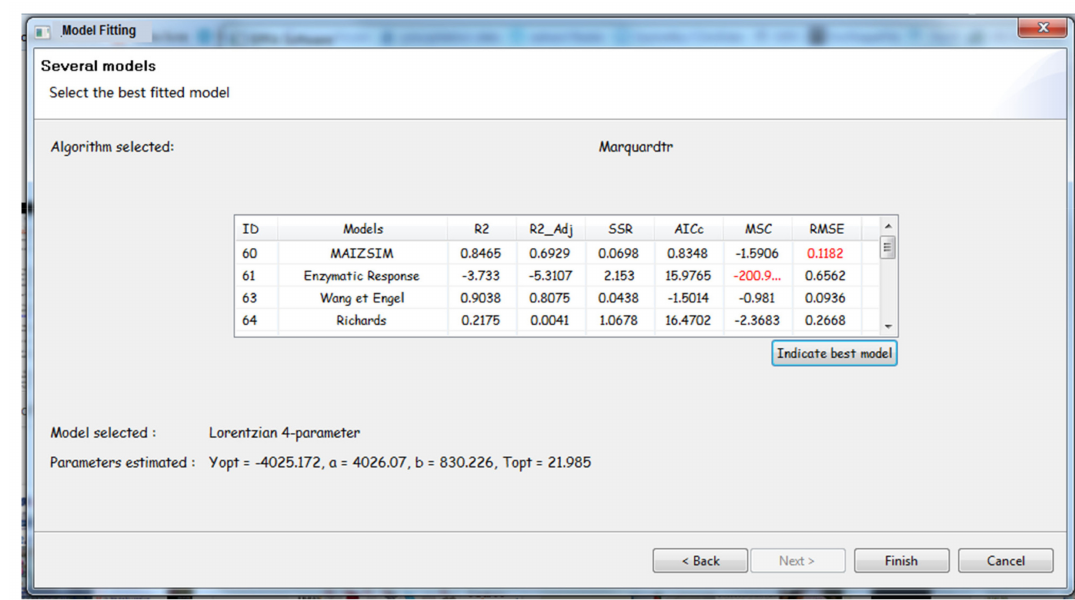
Figure 7. Evaluation criteria and goodness of fit for each fitted equation. Cells in red suggest the best-performing function for each evaluation